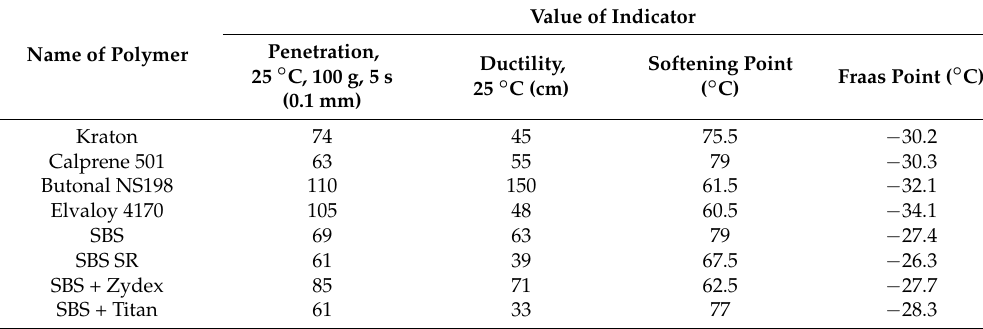
Table 3. Main standard indicators of the modified